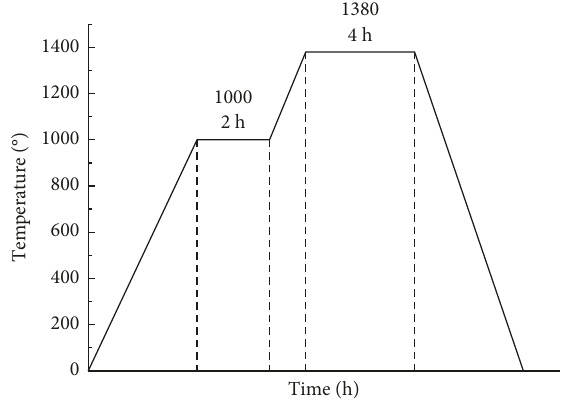
Figure 1: Process of C